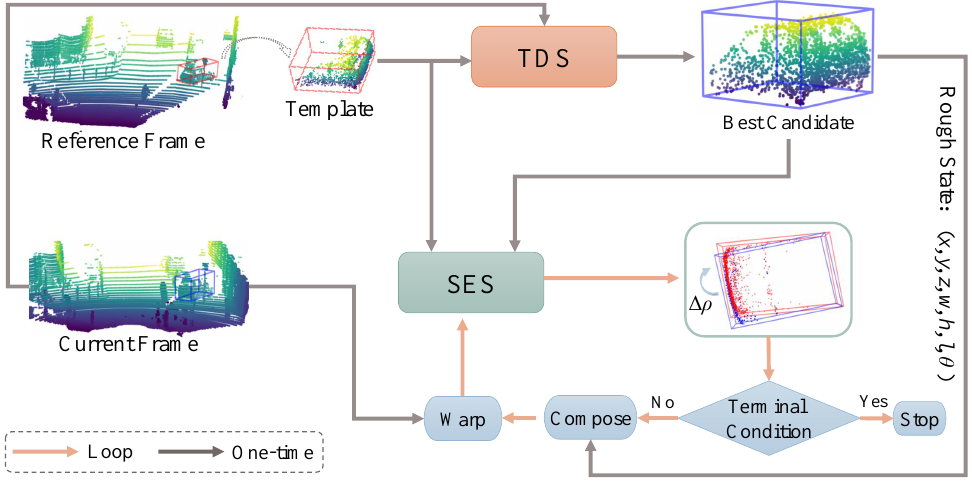
Figure 1. Overview of the proposed method for 3D point cloud tracking. During online tracking, the TDS first provides a rough state of the best candidate. Afterwards, provided with the template from the reference frame, the SES produces the incremental warp of the rough state. It is implemented itera- tively until the terminal condition ( (cid:107) ∆ ρ (cid:107) < (cid:101) ) is satisfied. The state estimation subnetwork (SES) and the target determination subnetwork (TDS) are separately trained using the KITTI tracking